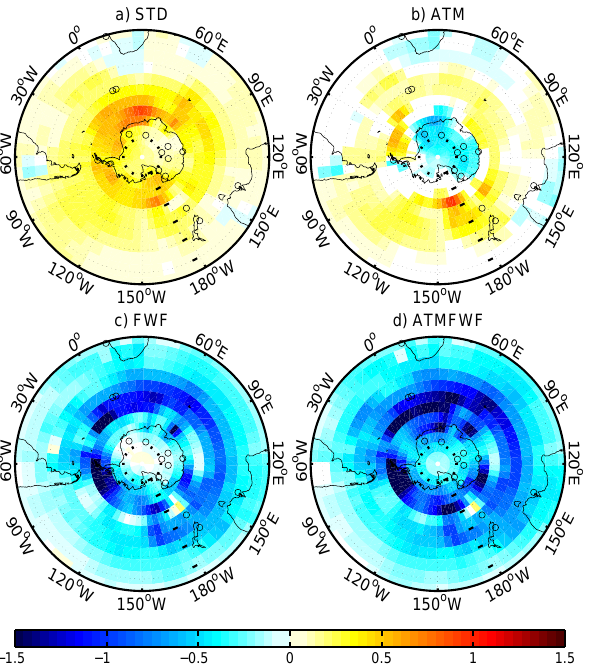
Fig. 2. Difference of the annual mean atmospheric surface tempera- ture between 8 and 10ka (8ka minus 10ka) for (a) STD, (b) ATM, (c) FWF, (d) ATMFWF. Colored areas correspond to differences significant at the 99% level according to a Student t test. Table 3. Mean absolute error (MAE) in ◦ C of the various sim- ulations (STD, ATM, FWF and ATMFWF) for Antarctic and the oceanic Southern Ocean temperatures. For each region and experi- ment, the MAE is computed by the average of the absolute value of the deviations between 8 minus 10ka anomalies from recon- structions and model at the same location. Records considered as Antarctic records or Southern Ocean records are described in Ta- ble 1a and b.